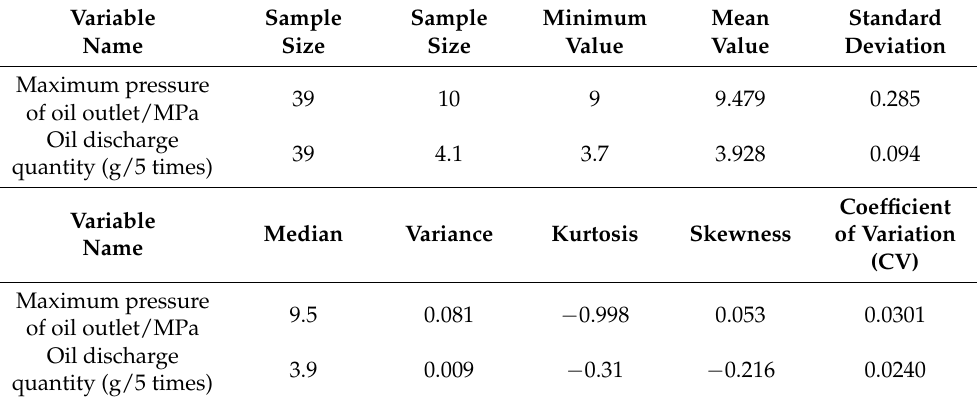
Figure 13. Oil discharge quantity of the grease suction and drainer devices after 12,000 fatigue tests. Table 6. Results of descriptive statistics of grease discharge performance after 12,000 fatigue